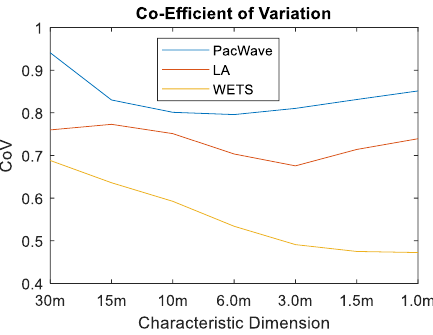
Figure 13: Co-efficient of Variation (CoV) for different WEC